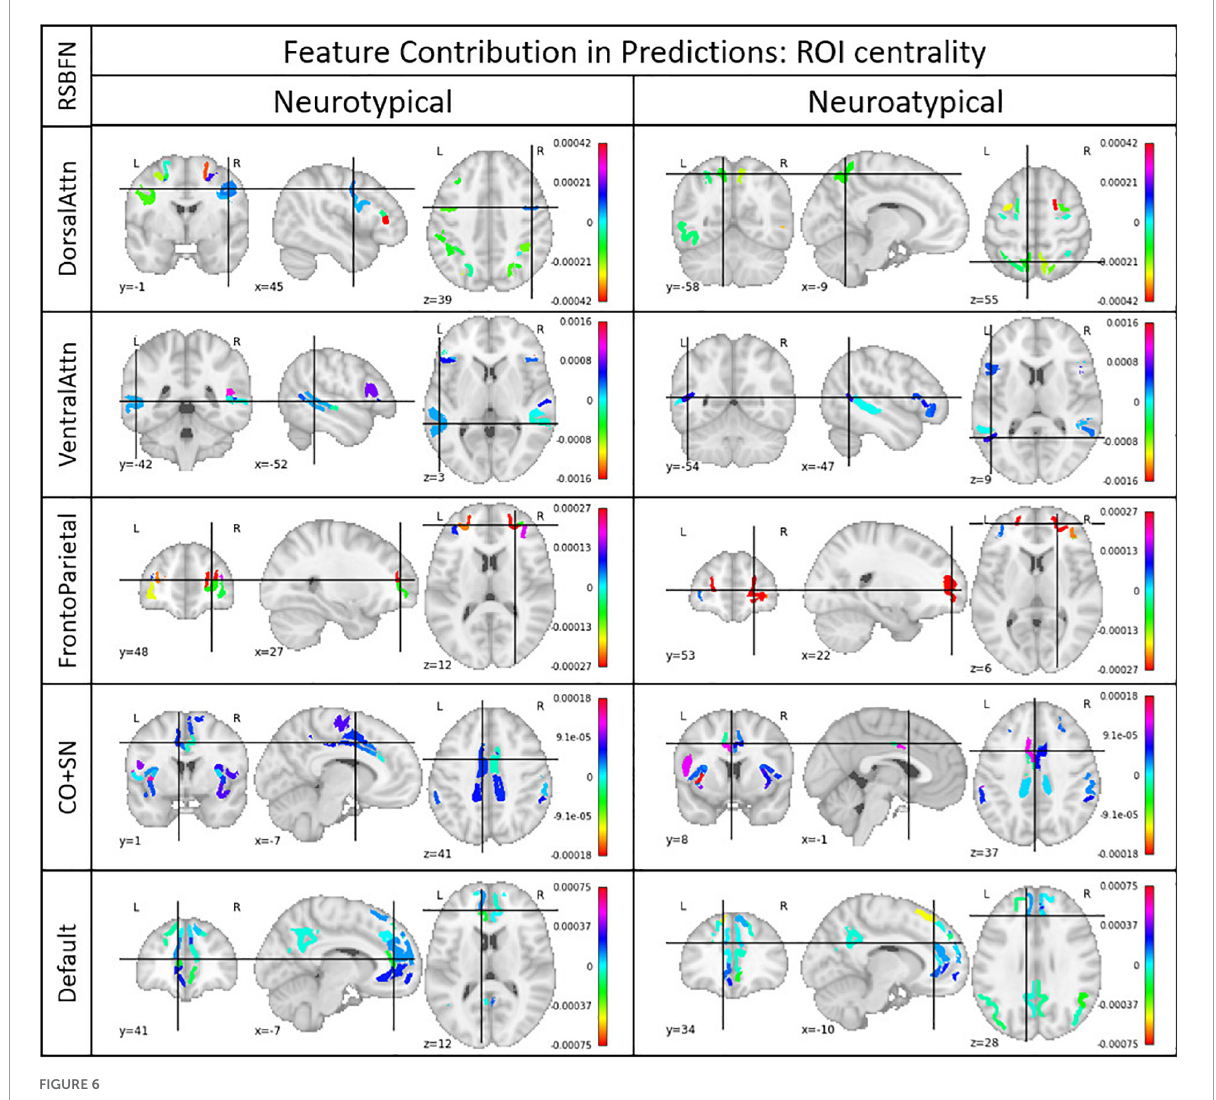
FIGURE6 Regions of interest (ROI) centrality. Each ROI belonged to a Resting State Brain Functional Network (RSBFN) and only intra-RSBFN relations were considered. The referred models presented the highest accuracy among the architectures tested for their specific datasets. Centrality (color bar) was derived from the average connection importance in predictions across neurotypical and neuroatypical subjects. Positive values indicate ROIs whose connections raised the neurotypicality score while negative values indicate ROIs whose connections lowered this metric. High values (in module) indicate great importance for the neurotypicality score. Group separation aims to ensure that the group’s neurological differences are excluded as confounding